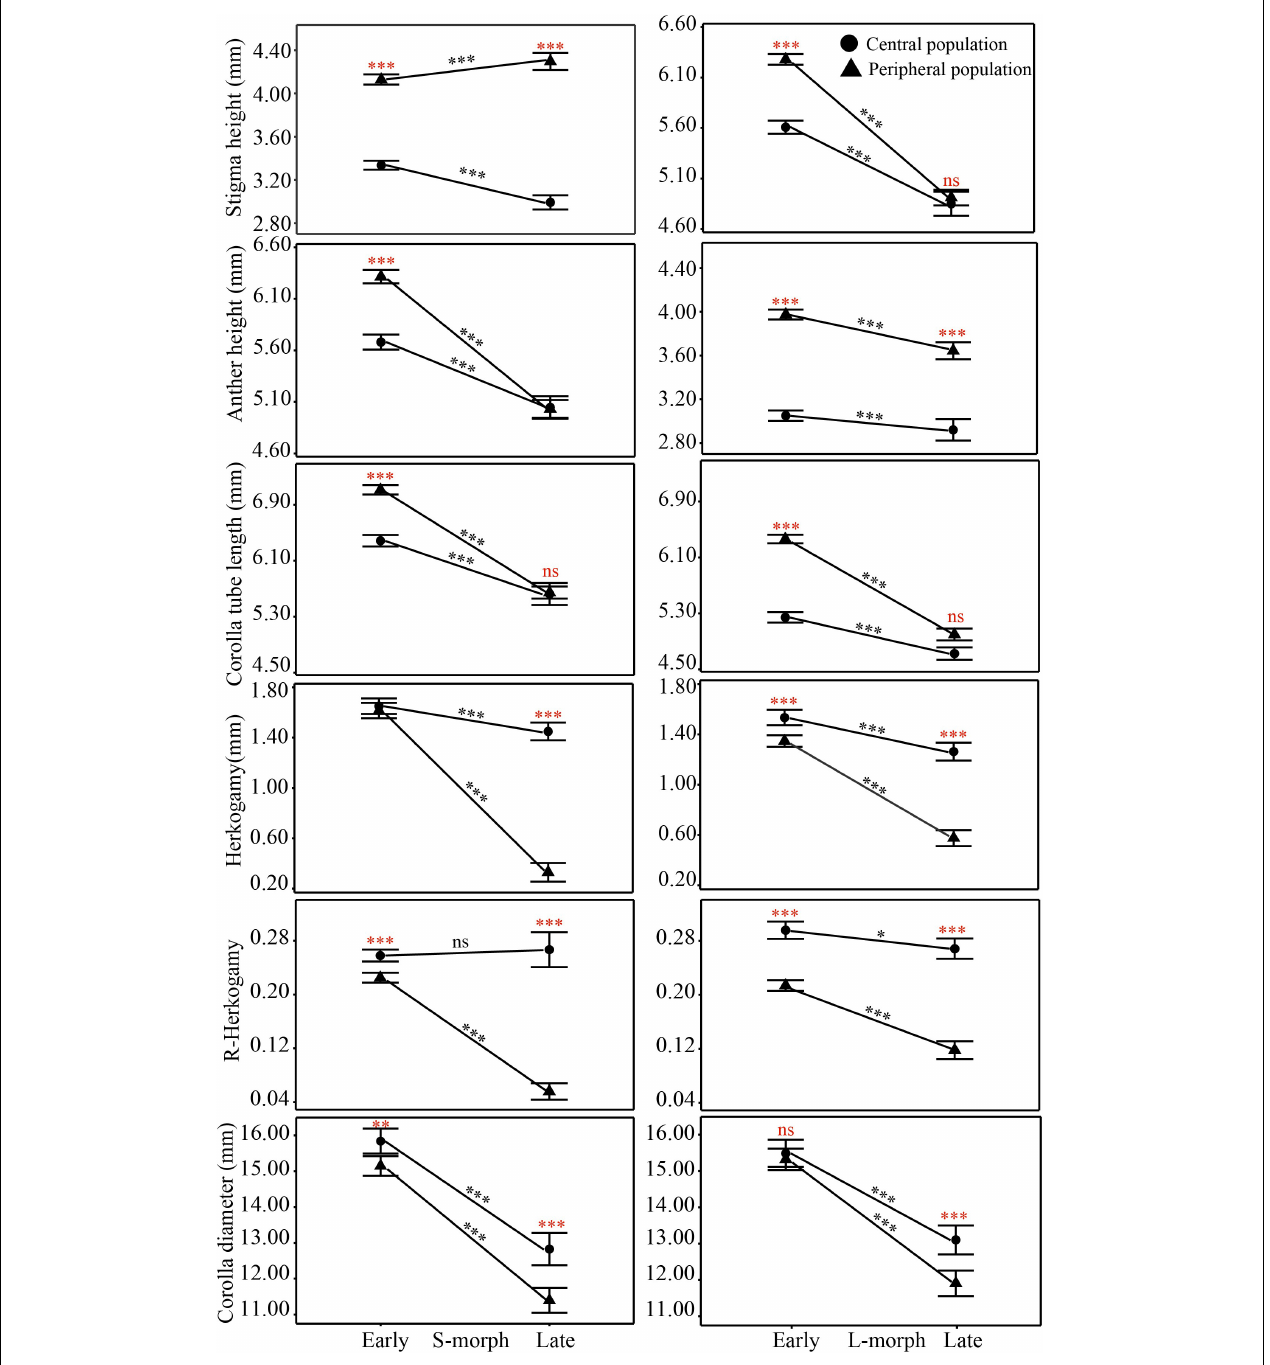
FIGURE 3 | Spatiotemporal differences in floral traits of P. wannanensis plants between different sites and between different florescence stages. Data represent mean ± standard error (SE). The red asterisk ( ∗ ) indicates significant differences between central and peripheral sites, and the black asterisk ( ∗ ) indicates significant differences between early and late florescence phases. **indicate significance level: P < 0.01 and ***indicate significance level: P < 0.001.